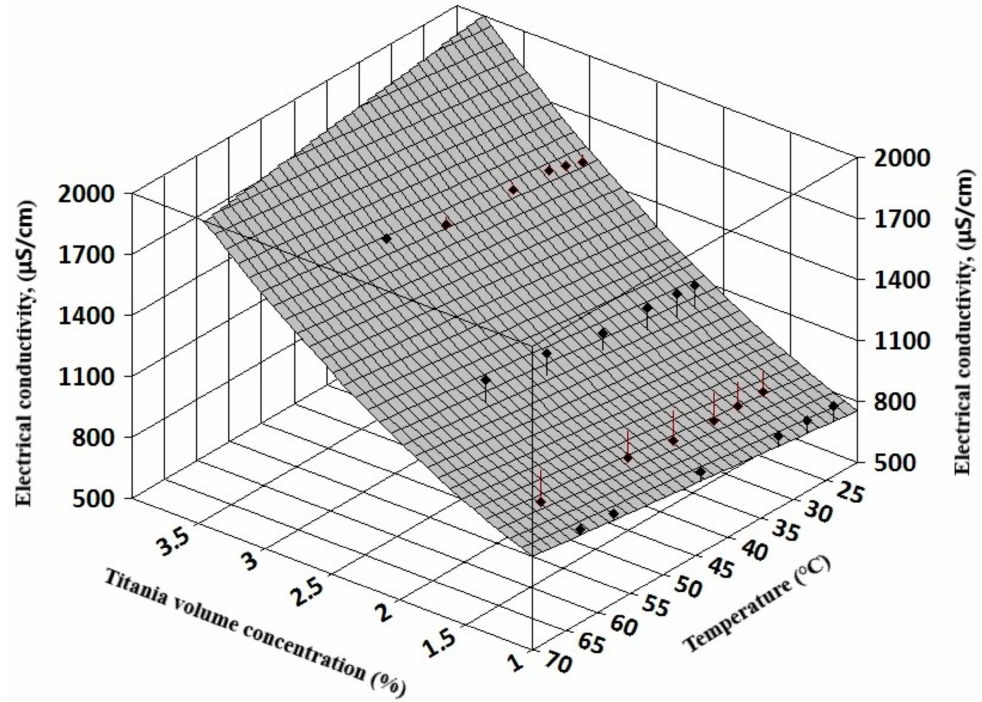
Figure 8. Three-dimensional analysis on titania